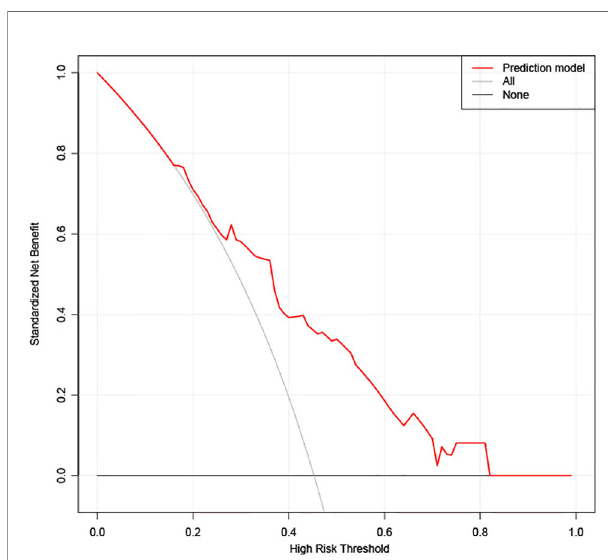
FIGURE 6 | Decision curve analysis (DCA) for the extreme gradient boosting (XGBoost) classi fi er. The y-axis represents the net bene fi t. The gray line represents the hypothesis that all patients had high CD8 + T-cell in fi ltration. The black line shows the hypothesis that all patients had low CD8 + T-cell in fi ltration. The x-axis shows the threshold probability, which is where the expected bene fi t of treatment is equal to the expected bene fi t of avoiding treatment. The decision curves show that with a threshold probability greater than 0.16, using the prediction model to predict CD8 + T-cell in fi ltration adds more bene fi t than the treat-all-patients as high CD8 + T-cell in fi ltration scheme or the treat-none as low CD8 + T-cell in fi ltration scheme in the training